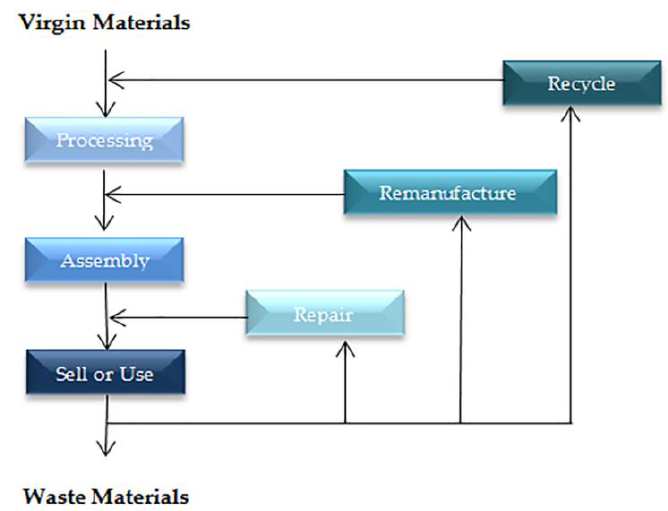
Figure 2. Closed loop design through repair, remanufacturing or recycling. Source: Author’s